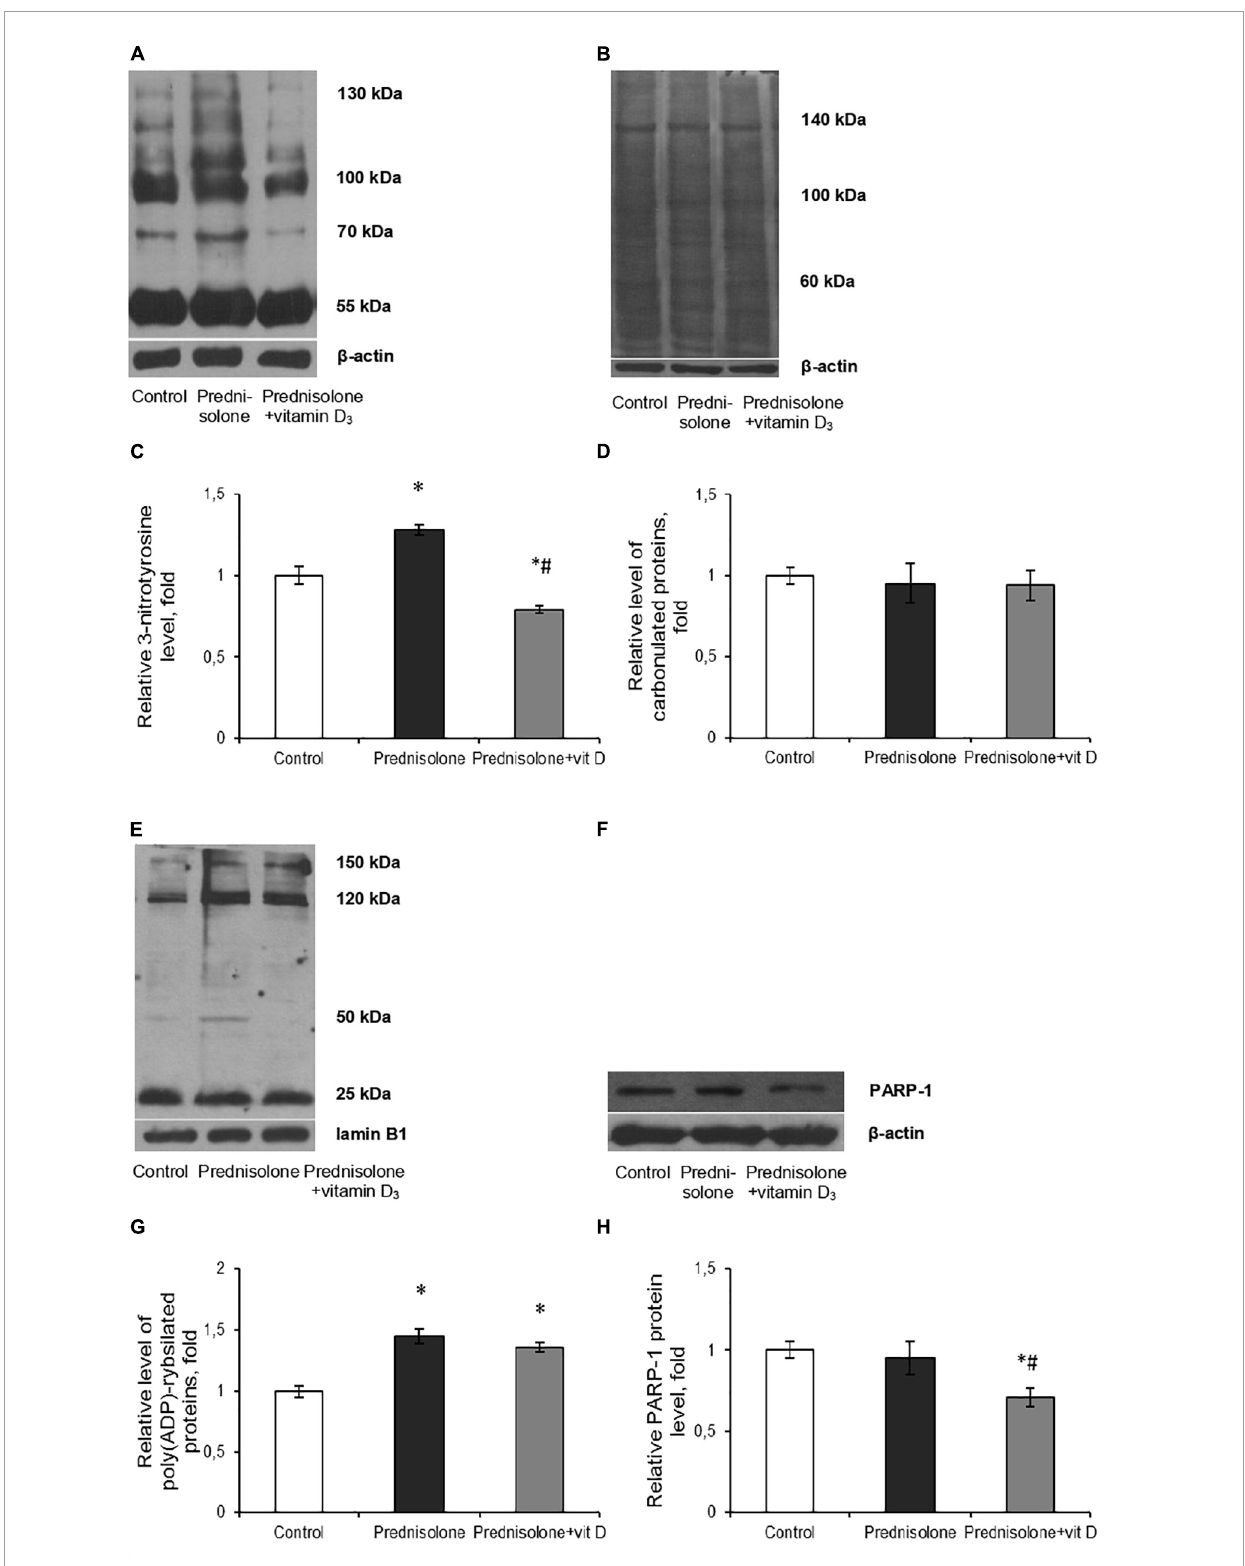
FIGURE8 Oxidative-nitrosative stress after prednisolone and vitamin D 3 administration. Levels of 3-nitrotyrosine (A,C) , carbonylated proteins (B,D) , poly(ADP)-rybosilated proteins (E,G) and PARP-1 (F,H) were determined by western blot analysis in rat brain tissue of three animal groups: 1—control; 2—prednisolone administration; 3—prednisolone and vitamin D 3 administration ( n = 8 rats/per group). Representative immunoblots are shown above the bar charts. Protein levels were normalized to β -actin and/or lamin B1. All data are presented as mean ± SD of three